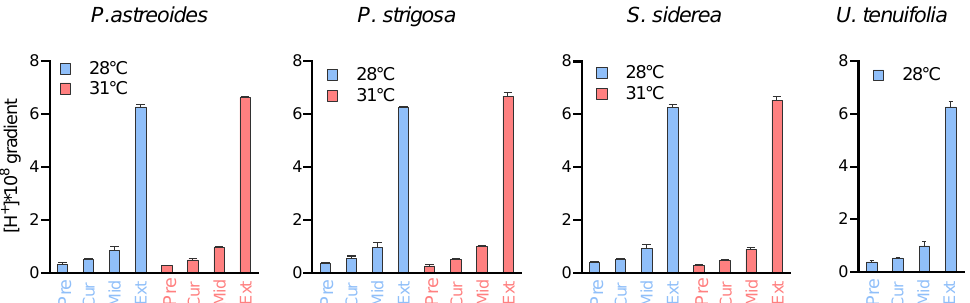
Figure 7. Proton differentials maintained by the coral species between seawater and their calcifying fluid ([H + ] SW − [H + ] CF ). Values are given for preindustrial, present day, mid-century, and extreme (~3300 ppm) p CO 2 conditions, with precise p CO 2 values given in Table S1. Calculated values are provided in Table S9.